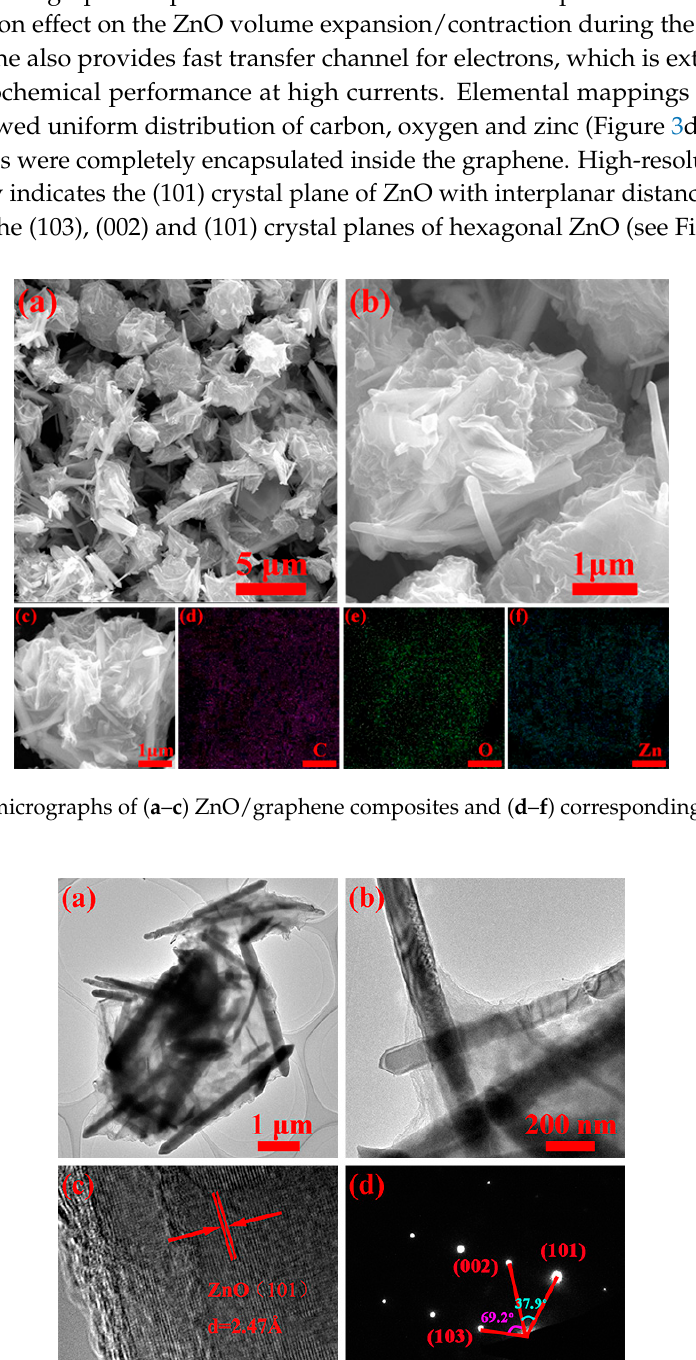
Figure 2. XRD pattern of the ZnO/graphene composites (top) in comparison with the XRD peaks of the pure ZnO from PDF #36-1451 (bottom).